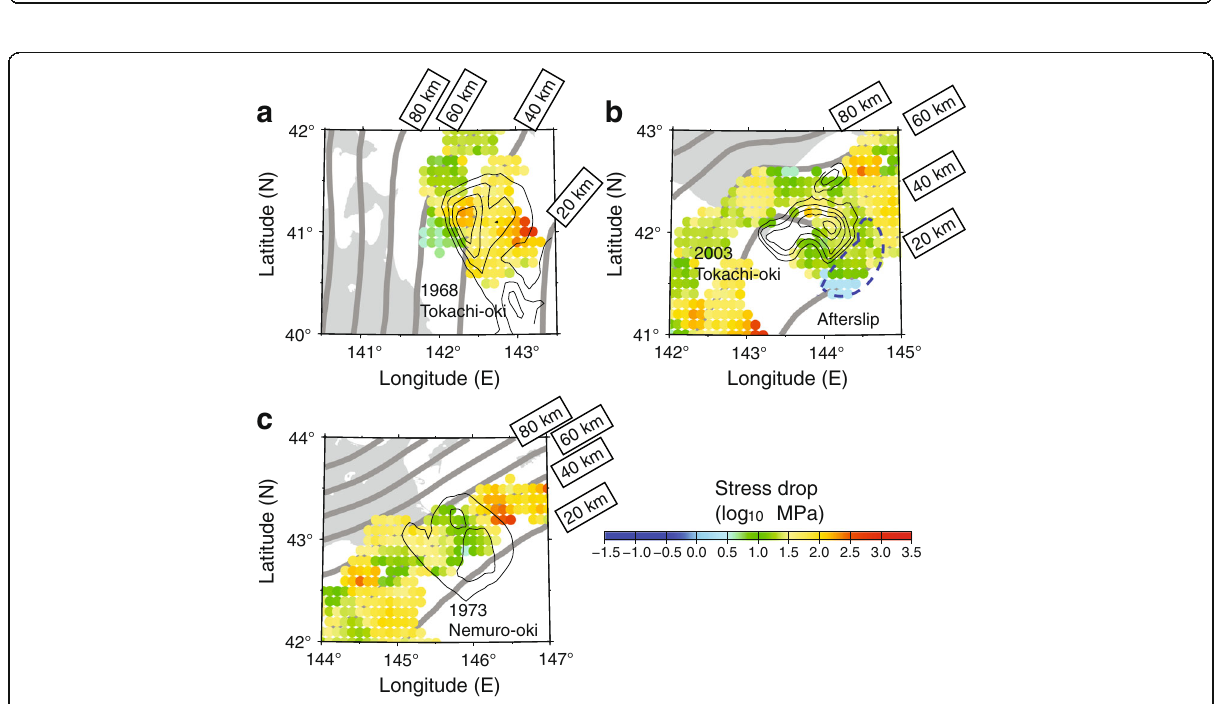
Fig. 5 Magnified images of the three coseismic source areas shown in Fig. 4d for a the 1968 Tokachi-oki (Nagai et al. 2001), b 2003 Tokachi-oki (Yamanaka and Kikuchi 2003), and c 1973 Nemuro-oki earthquakes (Yamanaka 2006). The interval of the coseismic slip is 1 m (as in Fig. 4). The dominant area of the afterslip following the 2003 Tokachi-oki earthquake is indicated by a broken blue line . Please refer to Miyazaki et al. (2004, 2004) for